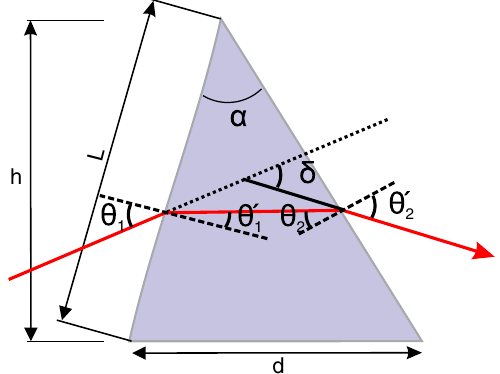
FIG. 6. Ray trace through a prism. θ 1 ; θ 0 1 ; θ 2 ; θ 0 2 are the incident and refractive angles at the first and second prism interface, respectively, α the prism apex angle, d , L , h are the geometric dimensions of the prism, and δ is the deflection angle with respect to the incident beam. Note the sign convention of the angles θ and δ , in which clockwise angles with respect to the surface normal have negative sign and vice